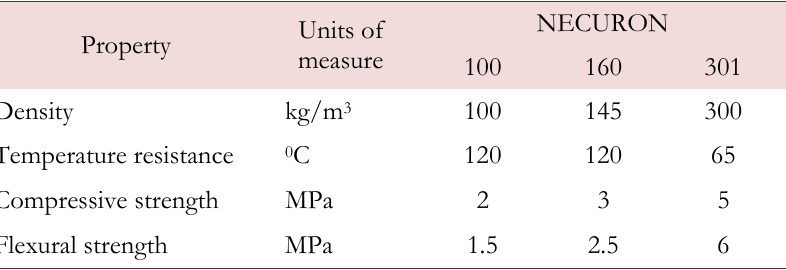
Table 5: Material properties according to manufacturer [22] (approximate